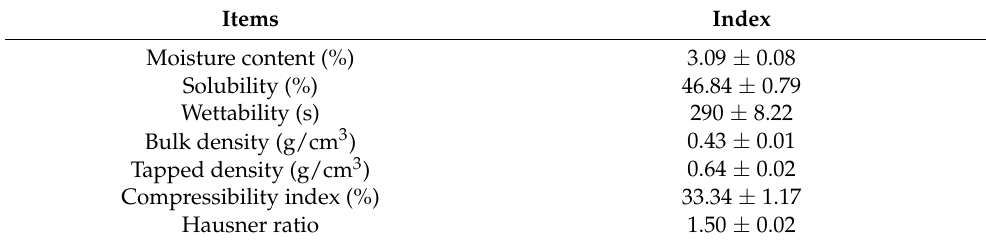
Table 3. Physicochemical properties of GLO